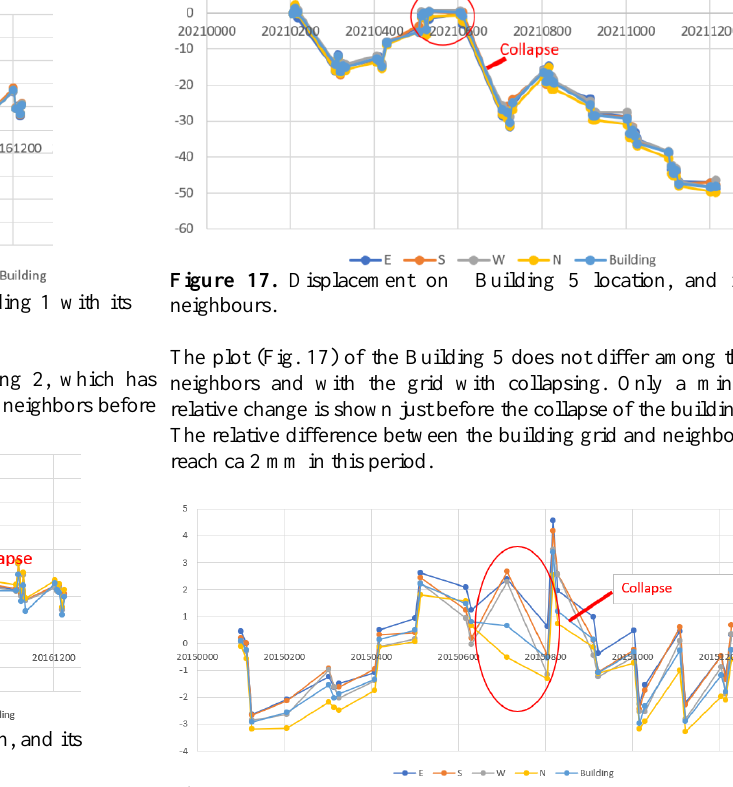
Figure 18. Displacement on Building 6 location, and its